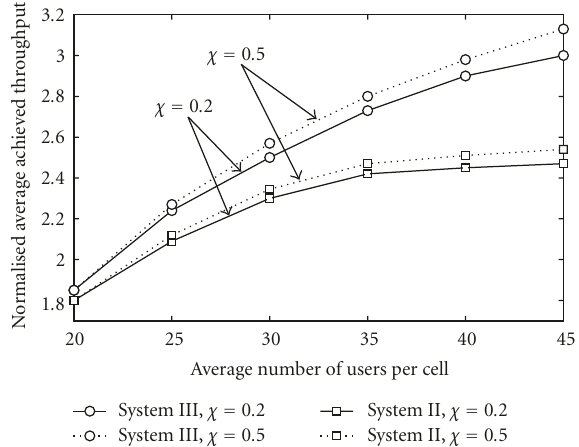
Figure 10: The normalized average achieved throughput of systems III and II versus the average number of users per cell.